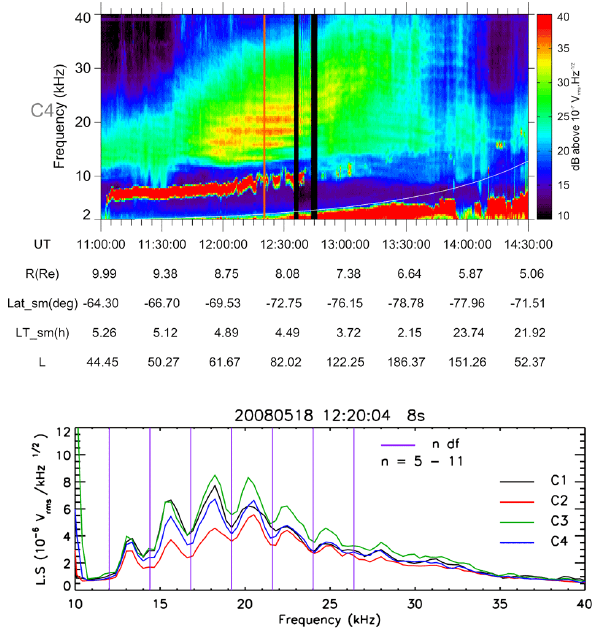
Figure 3. Spectral characteristics of the electric field measured by the Cluster constellation during the 18 May 2008 NTC event (after Décréau et al., 2013). Top: time–frequency spectrogram onboard C4. Bottom: Compared individual spectra at 12:20:04UT (orange line in top panel) for the four Cluster